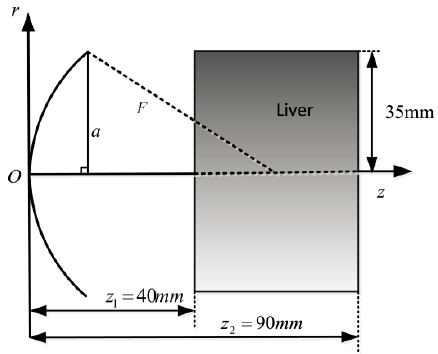
Figure 2. Geometric configuration of the physical model. The liver tissue is a cylinder with a radius of 35 mm and a length of 50 mm, and is placed at z 1 = 40